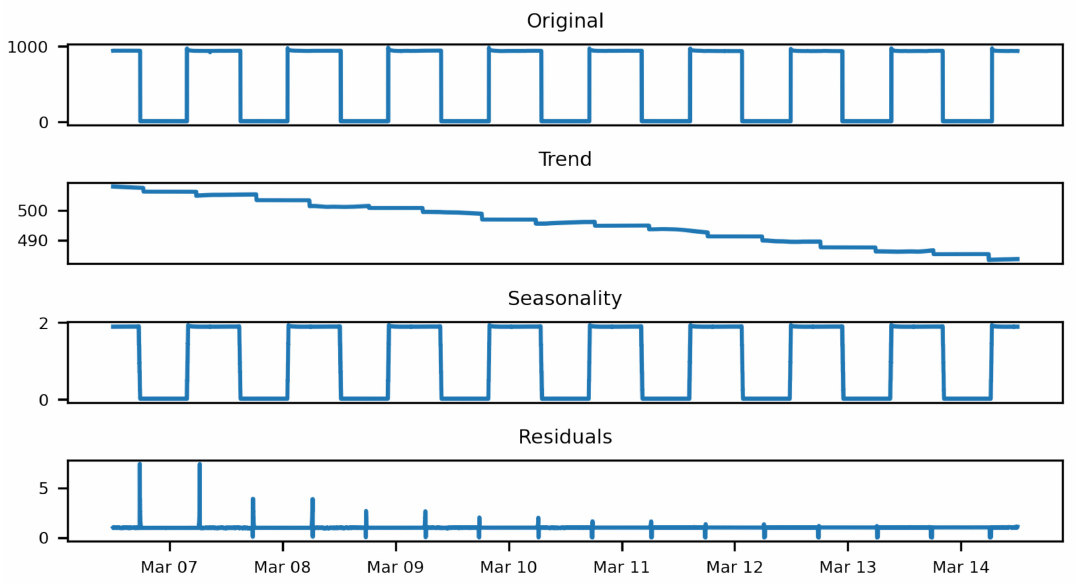
Figure 8. Decomposition of active power time series for the spring period.